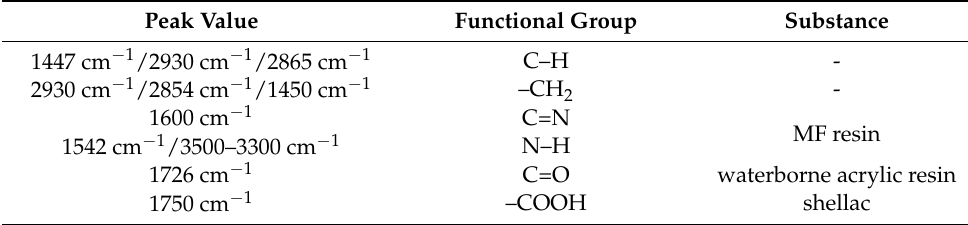
Table 8. Assignment of infrared absorption